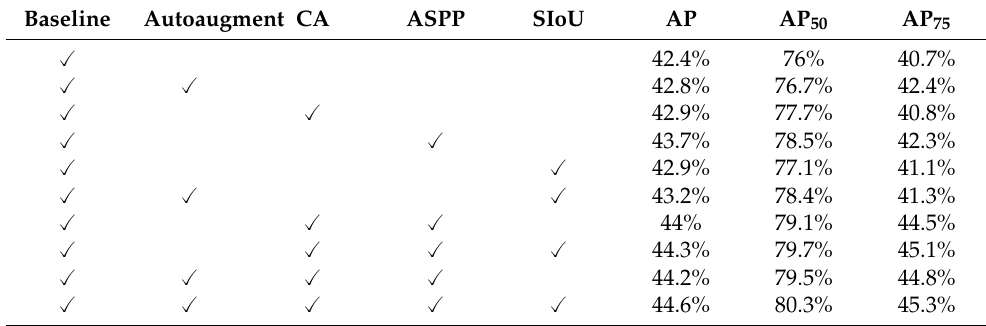
Table 3. Ablation study with different component combinations on the NEU-DET dataset.